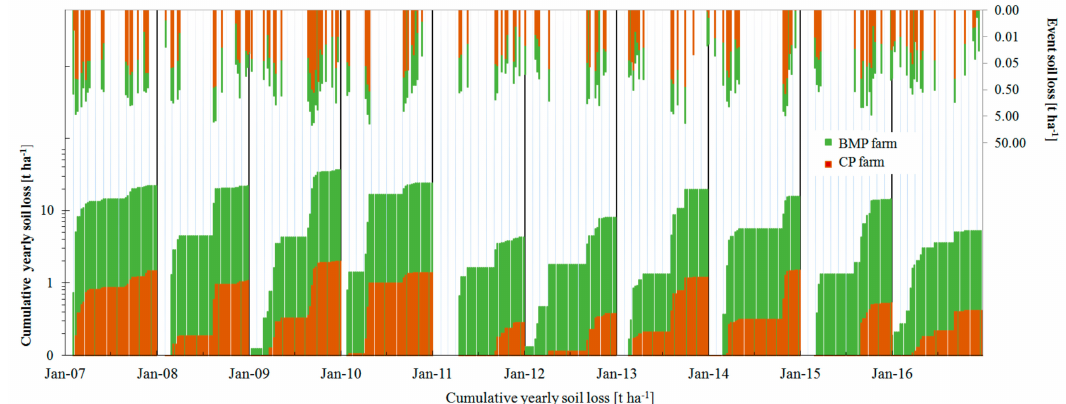
Figure 7. Event and cumulative yearly soil loss estimated using RUSLE model for the two vineyard plots during the investigated